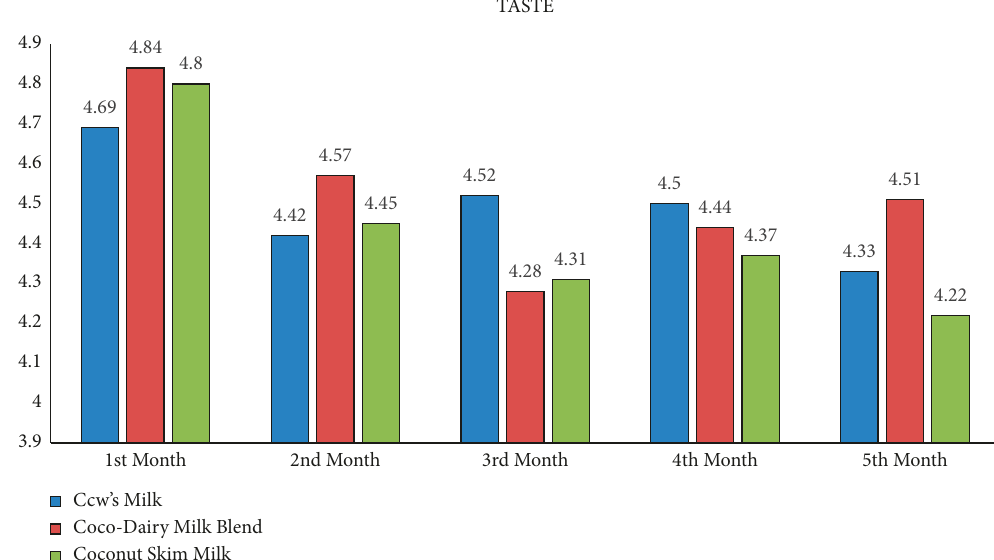
Figure 3: Average acceptability scores of milk products according to taste by